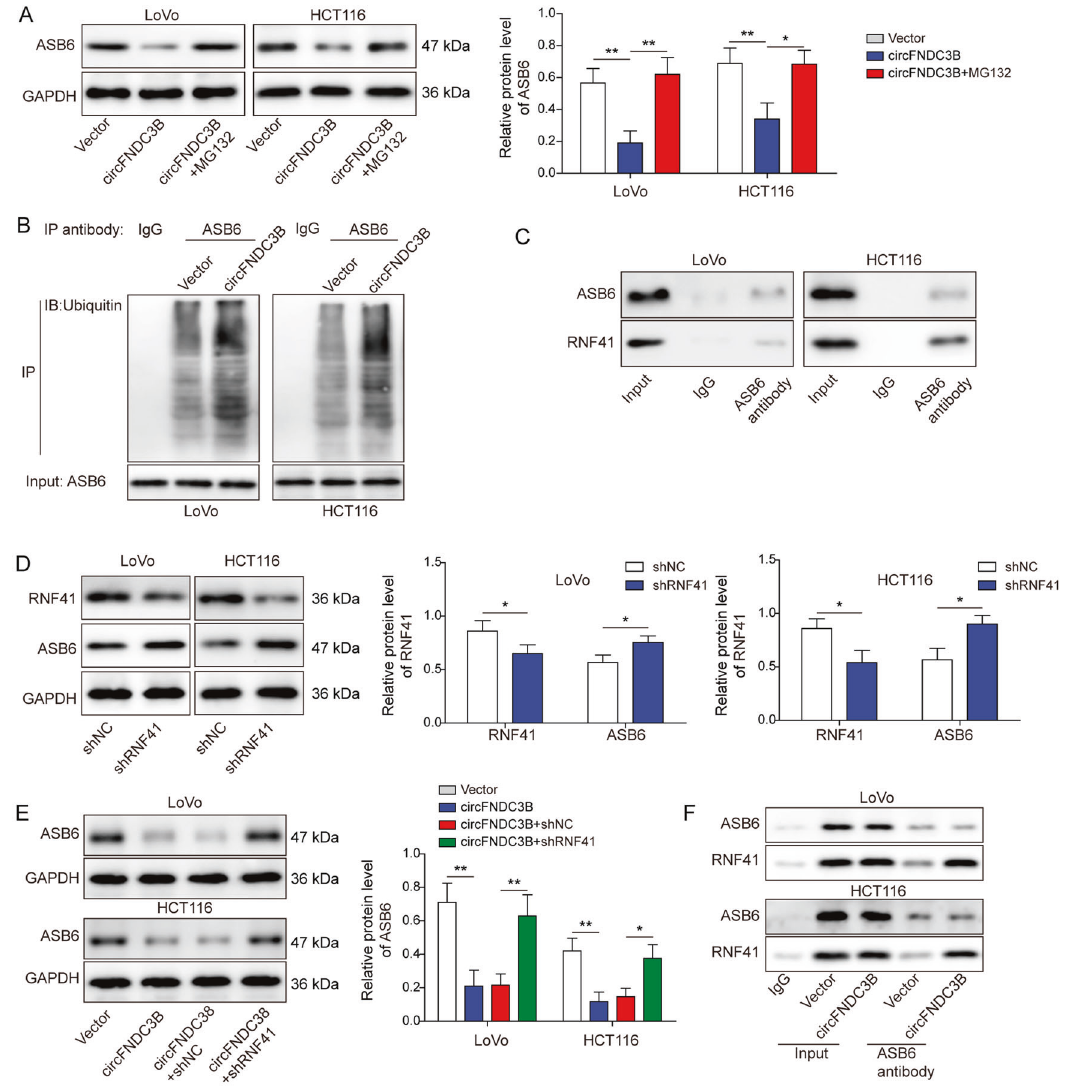
Fig. 6 circFNDC3B promotes ASB6 degradation through RNF41-mediated ubiquitination. A The protein level of ASB6 was determined by western blotting with quantitative analysis. B The ubiquitination of ASB6 was assessed by co-IP in transfected CRC cells. C The interaction between ASB6 and RNF41 was detected by Co-IP. Normal IgG served as a negative control. D The protein levels of RNF41 and ASB6 were determined by western blotting with quantitative analysis in transfected CRC cells. E The protein level of ASB6 was determined by western blotting with quantitative analysis in transfected CRC cells. F The interaction between ASB6 and RNF41 in circFNDC3B-overexpressing cells was detected by Co-IP. * P < 0.05, ** P < circFNDC3B-or RNF41-overexpressing xenograft tumors (Fig. 9I). IHC analysis further con fi rmed the circFNDC3B- or RNF41-mediated downregulation of ASB6 in tumor tissues, and the proliferation marker Ki-67 and stemness marker CD133 were also reduced by circFNDC3B or RNF41 overexpression in vivo (Fig. 9J). In vivo liver metastasis study revealed that circFNDC3B or RNF41 overexpression inhibited liver metastasis in which the number of metastatic nodules was decreased in circFNDC3B- or RNF41-overexpressing groups (Fig. 9K, L). Collectively, these data indicate that circFNDC3B or RNF41 overexpression suppresses tumor growth, stemness and liver metastasis via modulating ASB6 in vivo.